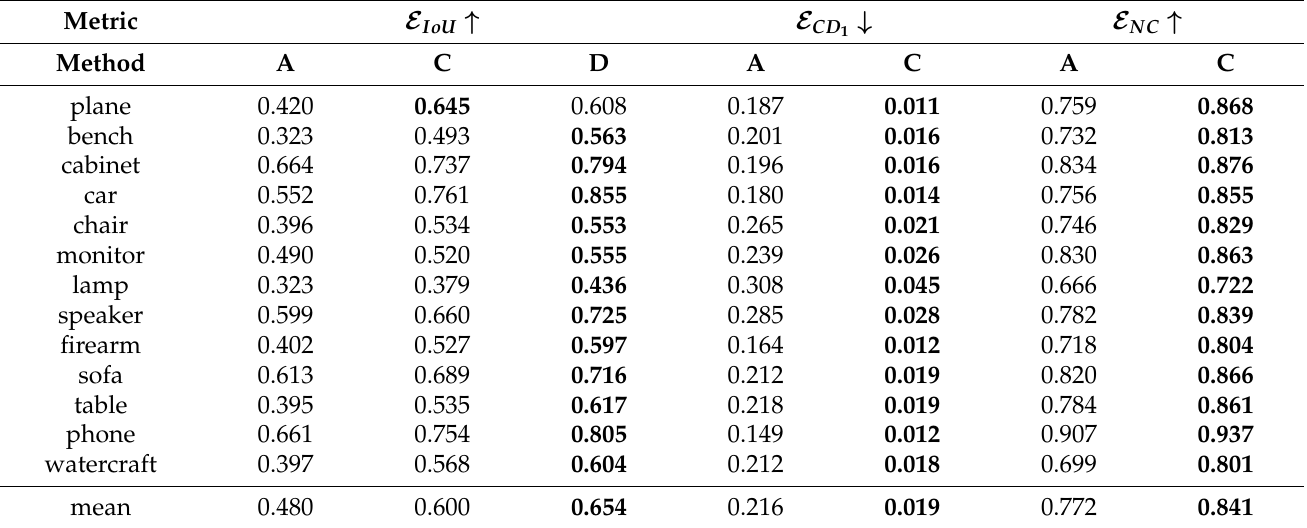
Table 8. Comparison of ( A ) Pixel2Mesh [7], ( C ) Salvi et al. [8] and 3D-VRVT [41] on the Choy et al. [18] subset of the ShapeNet dataset [10]. With self-attention after ResNet layers, Ref. [8] improves IoU by 25%, normal consistency by 8.9%, and reduces the average Chamfer-L1 distance approximately 11 times. Ref. [41] further improves the IoU by 9% with a Vision Transformer architecture containing multi-headed self-attention. Bold values show the best results for each